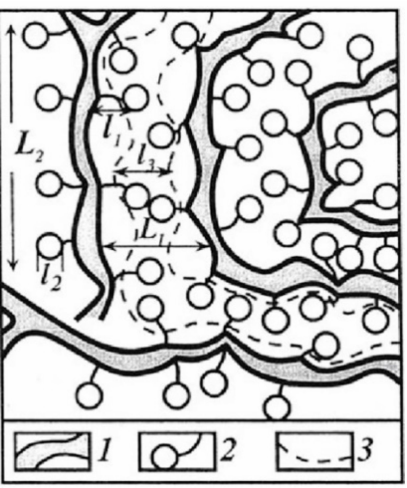
Figure 3. Structure of the amorphous part of a perfluorinated sulfonate cation-exchange mem- brane [5]. ( 1 ) Polymer backbone; ( 2 ) hydrated counter-ions and functional groups at a low moisture content; ( 3 ) transport channels for ions and water molecules at a high moisture content; L 1 = 4 nm according to small-angle X-Ray scattering data [84,85]; L 2 = 10 nm according to Mössbauer spec- troscopy [93]; l 1 = l.2–1 nm according to ENDOR and relaxation NMR data [96–99]; l 3 = 1.5 nm according to standard porosimetry [94] and ENDOR [98,99]